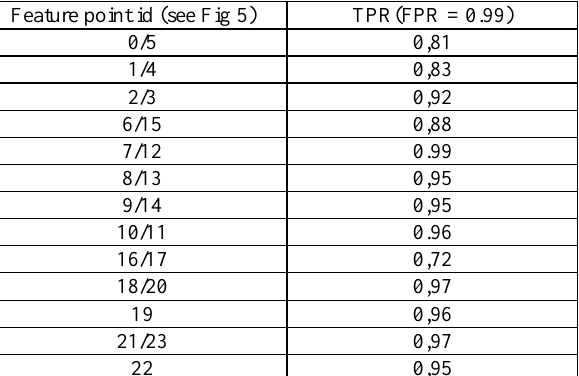
Table 1. Results on LFW